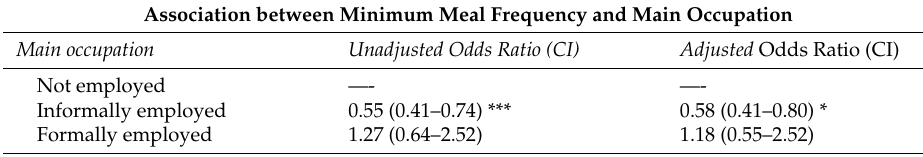
Table 3. Regression Analysis for Minimum Meal Frequency and Employment